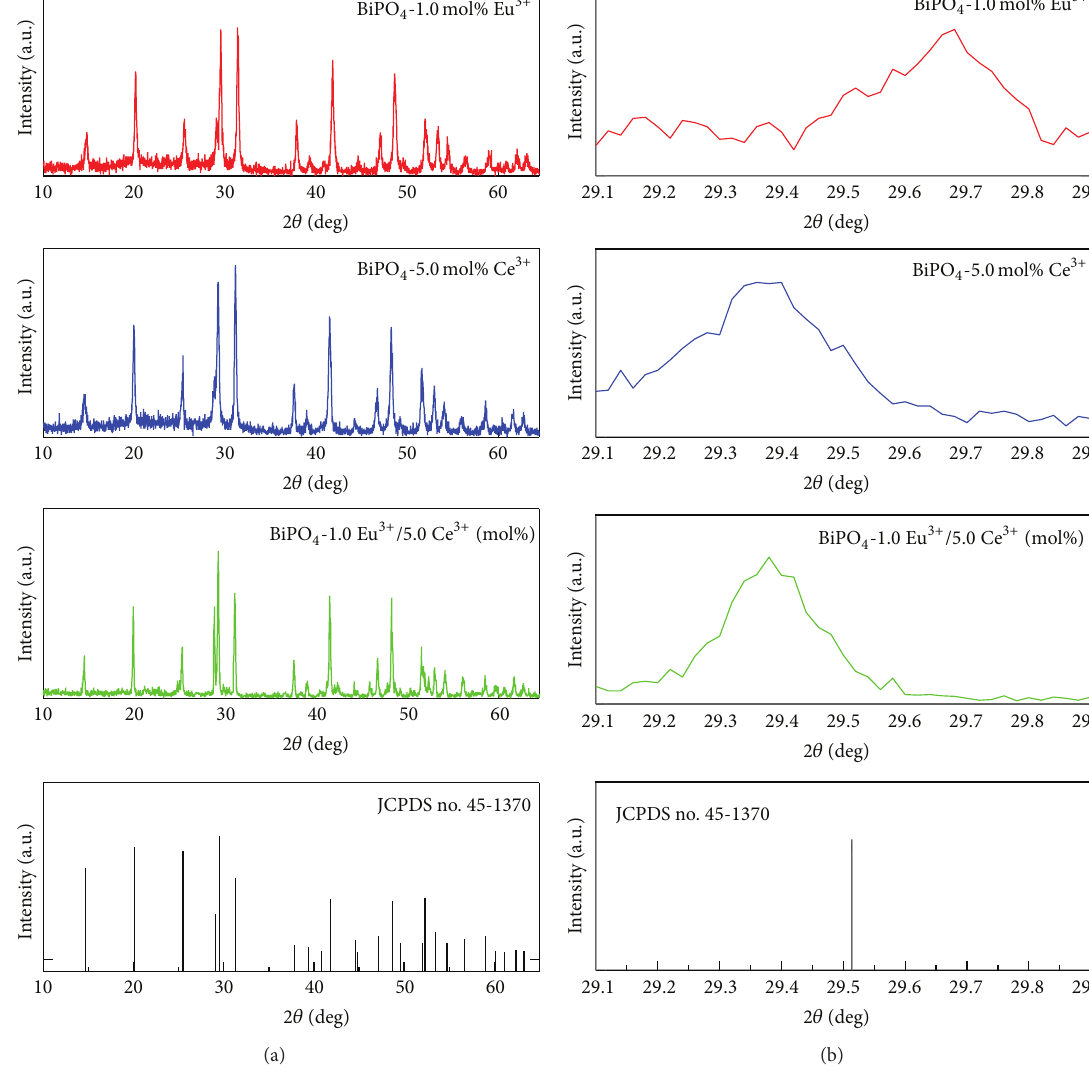
Figure 1: (a) XRD profiles of some of the synthesized samples, (b) XRD profiles in the range 29.1 to 29.9 (2